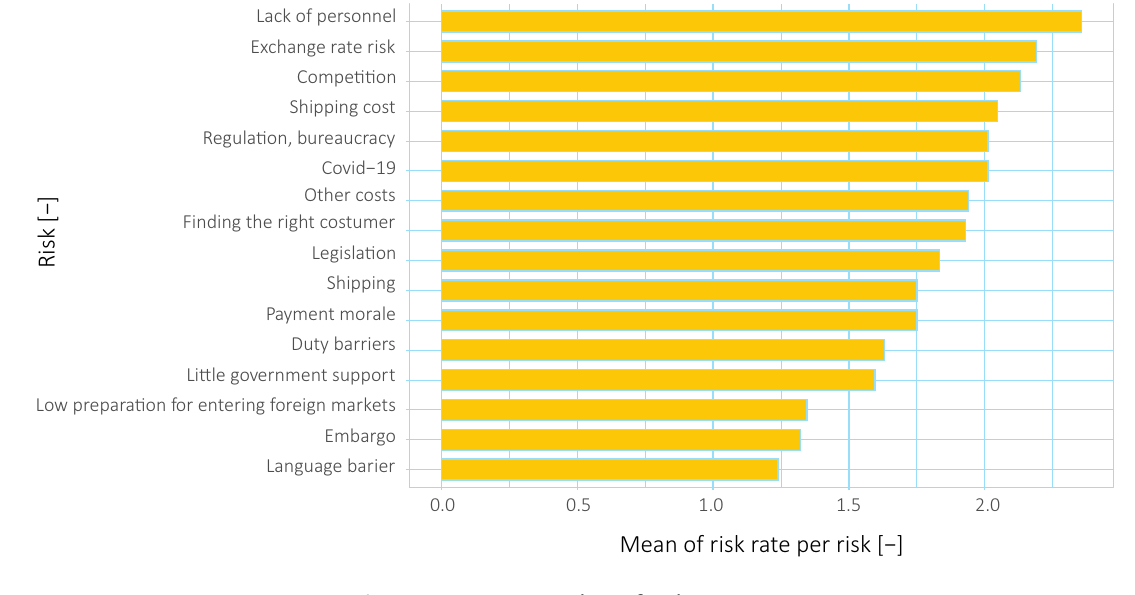
Figure 1. Average value of risk